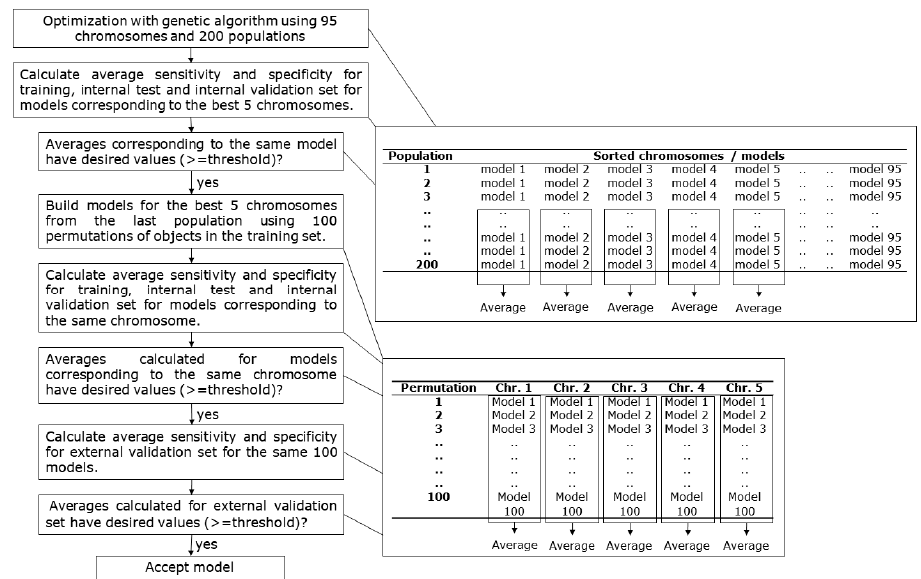
Figure 5. Schematic presentation of the model selection process.